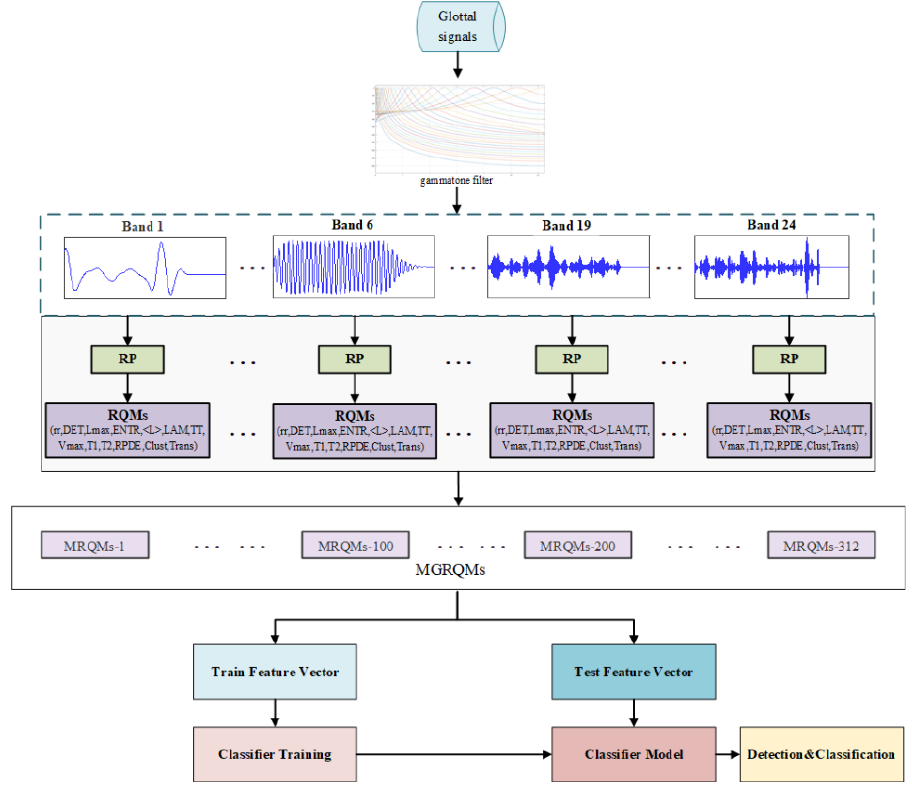
Figure 1. The framework of MRQMs extraction for pathological voice detection and